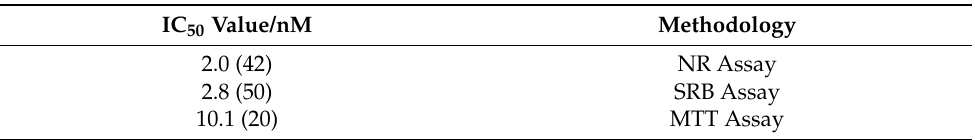
Figure 4. Effects of PTX on the viability of MCF-7 cells determined by ( A ) NR, ( B ) SRB, and ( C ) MTT assays. Cells were treated with increasing concentrations of PTX for 24 h and dose-response curves for each assay were obtained (right). For the construction of the dose-response curves, the data was normalized between 0% (lowest obtained value of cellular viability) and 100% (highest obtained value of cellular viability). The results are shown as the percentage of control and are expressed as the mean ± SEM of three independent experiments ( n = 3). * Statistically significant vs. control at p < 0.05; ** statistically significant vs. control at p < 0.01; *** statistically significant vs. control at p < 0.001; **** statistically significant vs. control at p < 0.0001. Table 2. Obtained IC 50 values, with respective methodologies, for the 24 h treatment of MCF-7 cells with PTX.